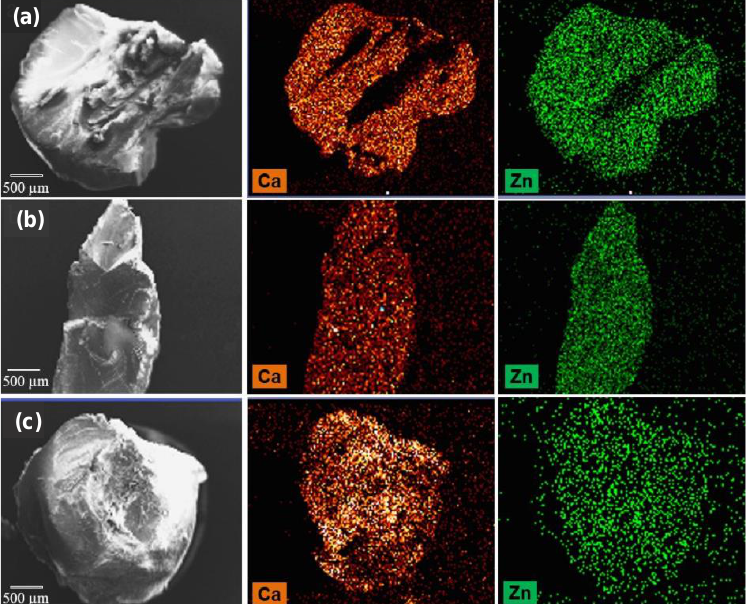
Figure 12. SEM and SEM-EDS microphotographs of cryofractured blank xerogel beads produced with different Ca 2+ /Zn 2+ ratios: ( a ) 1:1, ( b ) 1:4 and ( c ) 4:1. Reprinted from [201] with permission from Elsevier. Copyright (2017).